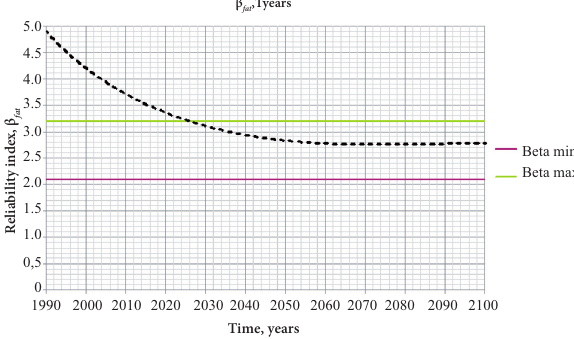
Fig. 9. Probabilistic modelling of the likelihood of failure, inferior flange at the midspan – detail 1(bending detail category with reference to EN 1993-1-9:2005 , C = 63) for a max stress excursion of 72